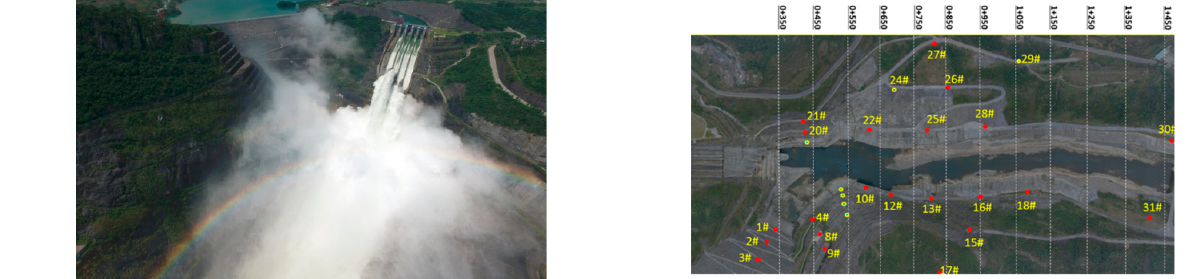
Figure 10. FDA scene and atomization rain intensity monitoring points of Shuibuya Hydropower Station.